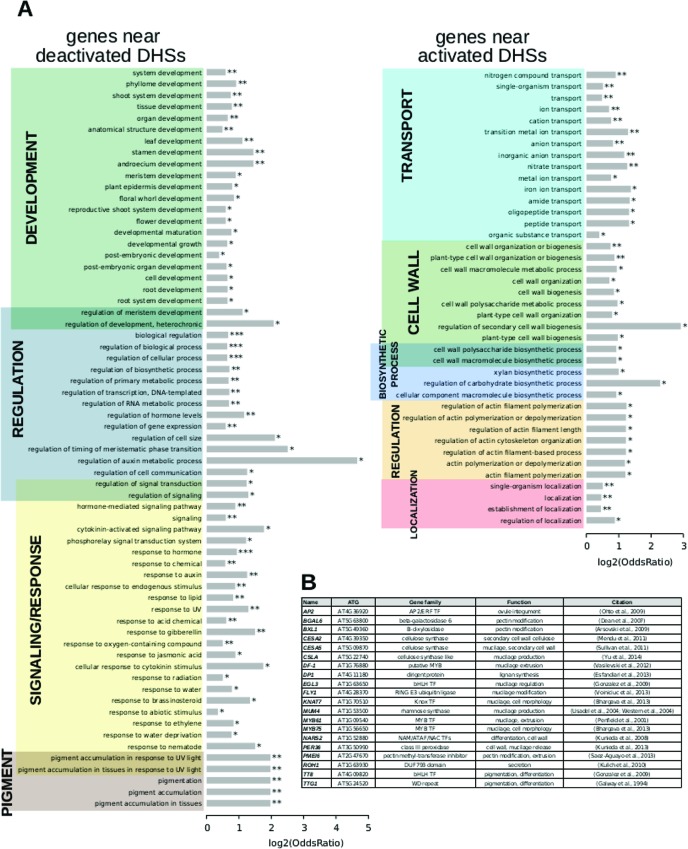
Term enrichment for genes nearest to dynamic DNase I-hypersensitive sites (DHSs). (A) Term enrichment for genes near DHSs that are deactivated (less accessible) or (B), activated (more accessible) at the 7 DPA time point.